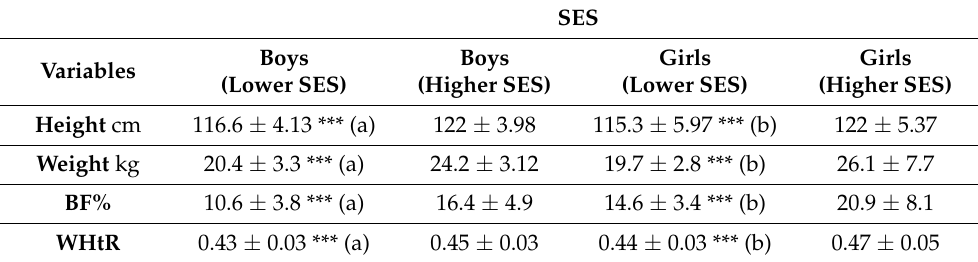
Table 4. Descriptive height and weight frame indices.